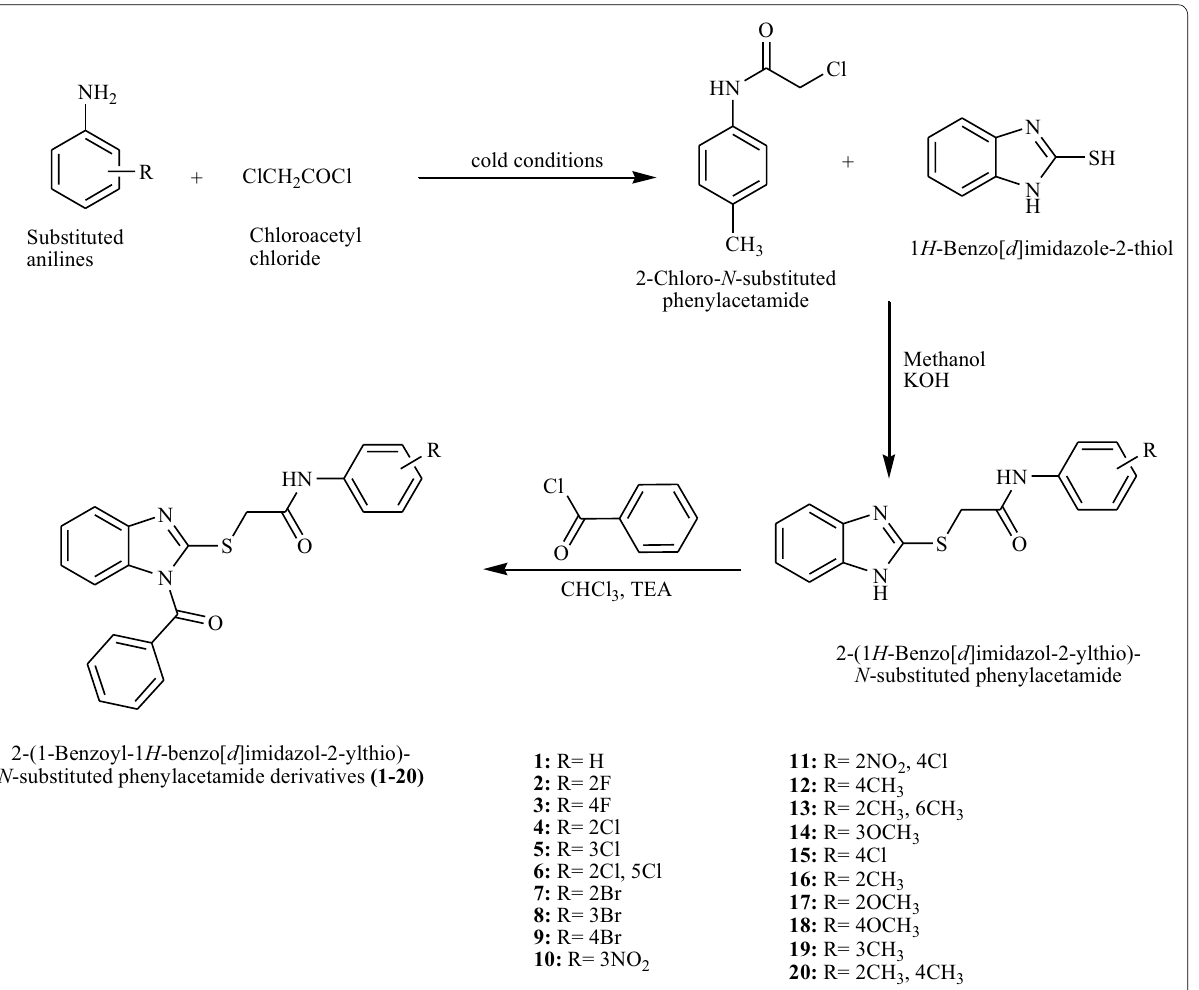
1. Electron withdrawing group fluoro at ortho and para positions (compounds 2 and 3 ) while nitro group at meta position (compound 10 ) improved anticancer activity. The presence of other electron withdrawing groups like Cl, Br at ortho , meta or para positions diminished the anticancer